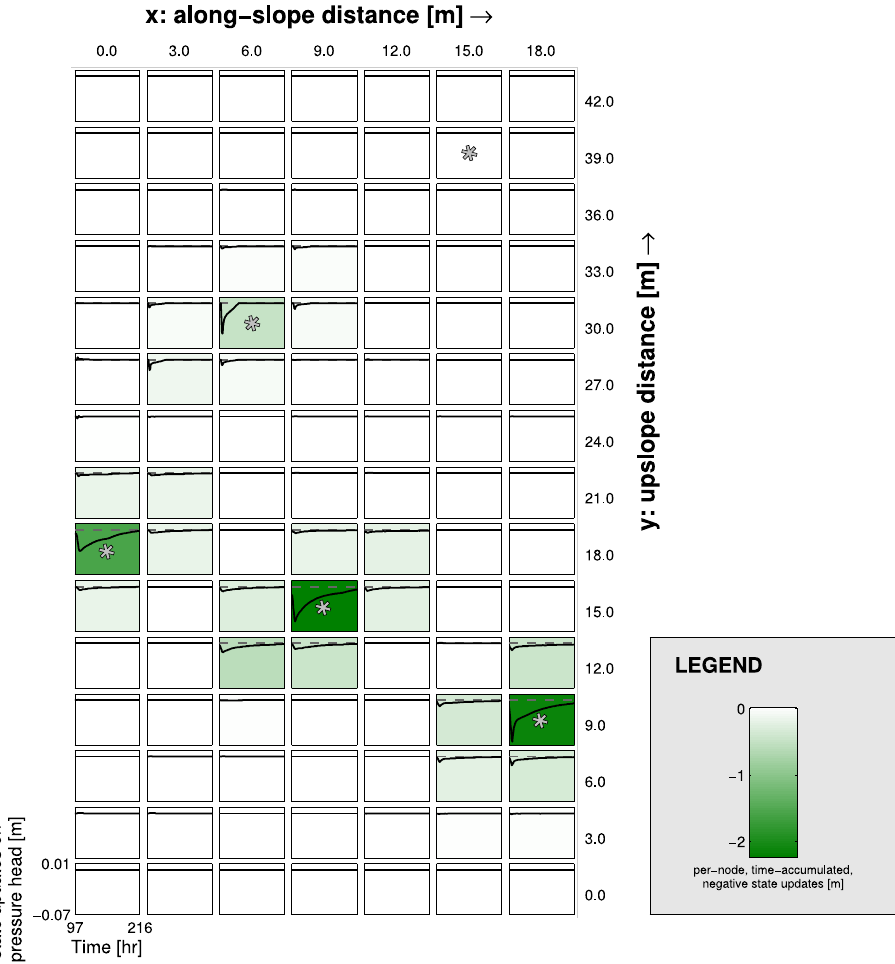
Fig. 7. SODA (idealized data set): pressure head state updates in space and time, as associated with the Pareto-optimal parameter combination log 10 (r sink ) ≈ − 1 . 97; log 10 (K s ) ≈ − 0 . 46. For each node at the soil–bedrock interface, the figure contains a subplot showing a time series of state updates (black line) for t = 97–216h. Horizontal dashed lines represent zero updates (no adjustment). To ease interpretation of the updating pattern, each subplot was assigned a background color that visually shows the magnitude of cumulative negative updating. Greener backgrounds mean stronger over-estimation (i.e. the model’s a priori value is too wet with respect to the artificial measurements). This figure uses a color scheme that is different from that of Fig. 5 to emphasize the difference in interpretation between model-observation residuals on the one hand and state updates on the other. The locations of sink hotspots as used in the reference model (but not the simplified model) are indicated with asterisks.